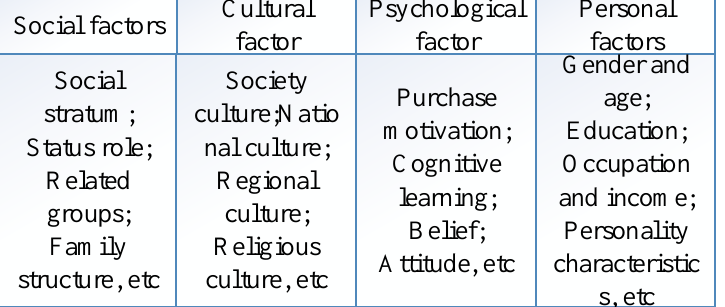
Figure 6. Influencing Factors of Consumer Buying Behavior.